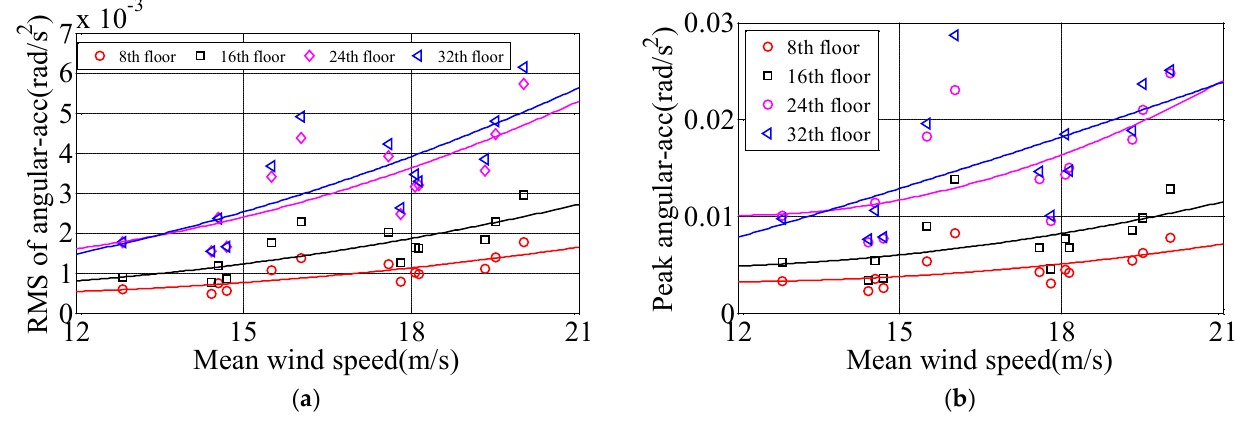
Figure 10. The relationship between the RMS of angular-Acc and peak angular acceleration with respect to the mean wind speed. ( a ) RMS of angular-Acc; ( b ) Peak angular accelerations. Table 3. The fitting results of torsional parameters of c 1 and c 2.